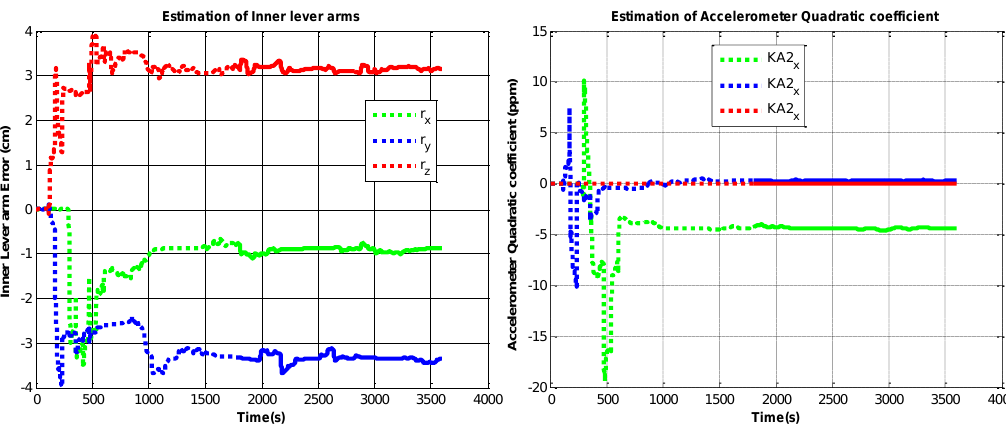
Figure 9. Estimation curves of inner lever arm and accelerometer quadratic coefficient errors.